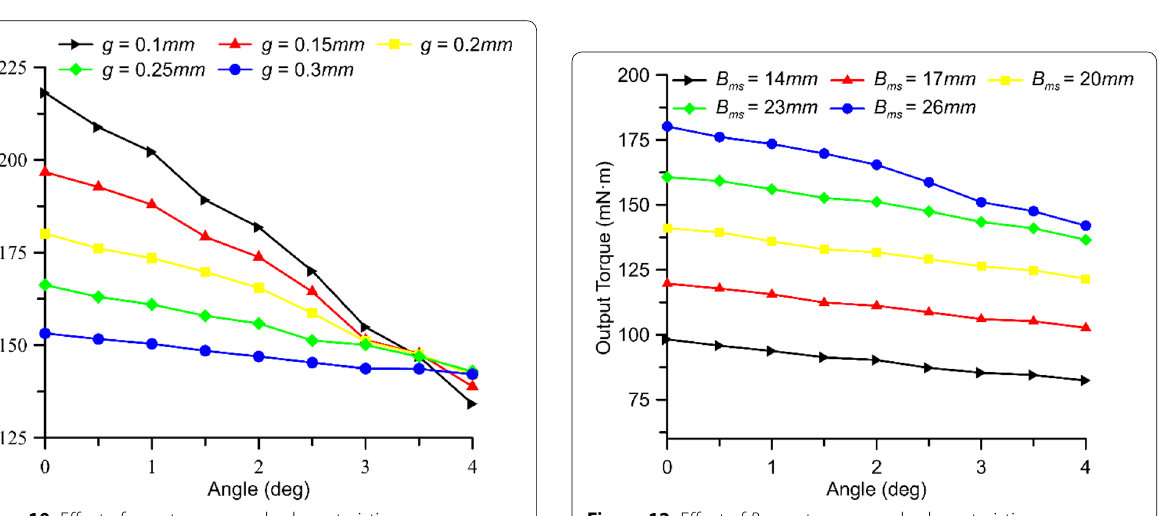
Figure 10 Effect of g on torque–angle characteristics